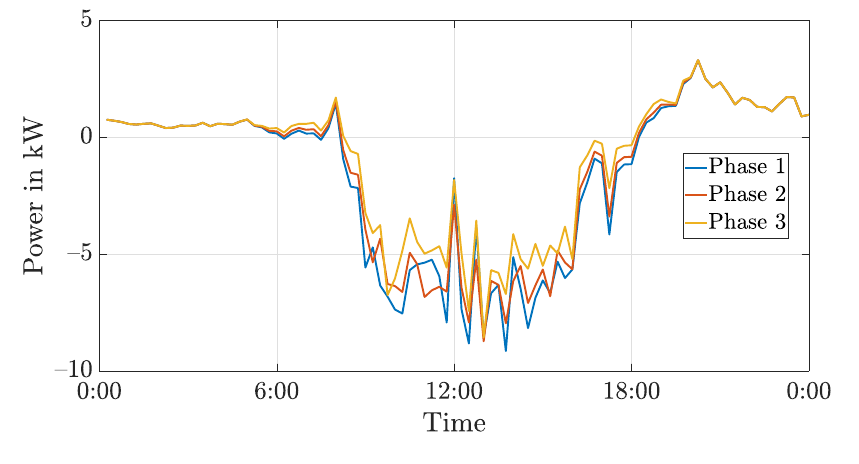
Figure 19. Total power import per